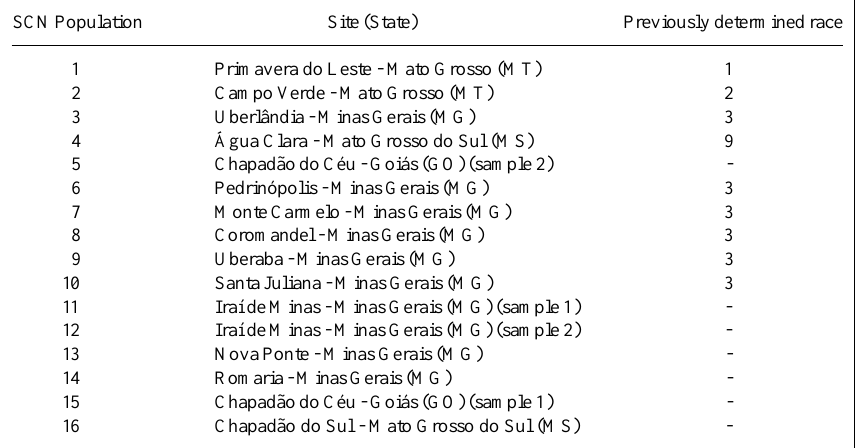
Table I - Populations of Heterodera glycines from Brazil used in this study.